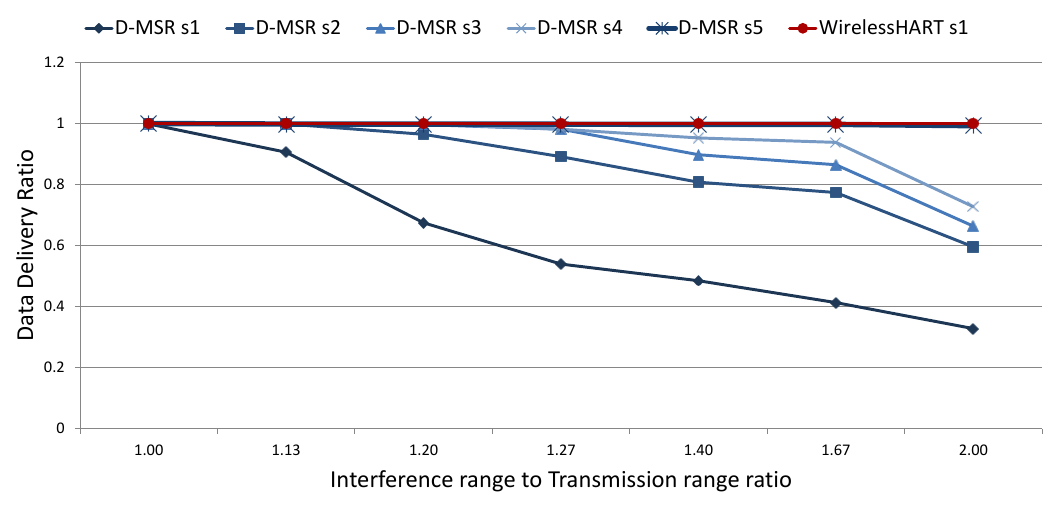
Figure 24. Data delivery ratio differences in case of internal interference.